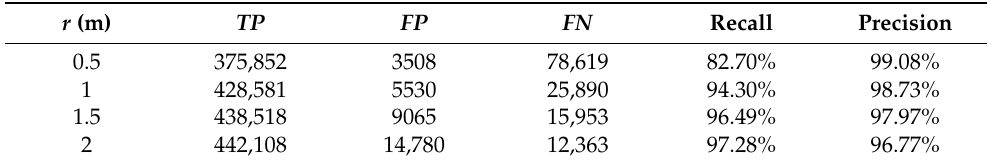
Figure 10. The results of the vegetation point clouds of the two plots after filtering out the building boundary point clouds. ( a ) Vegetation extracted using discrete feature of plot 1; ( b ) Result of filtering the building boundary of plot 1; ( c ) Vegetation extracted using discrete feature of plot 2; ( d ) Result of filtering the building boundary of plot 2. Table 2. The recall and precision evaluation results of plot